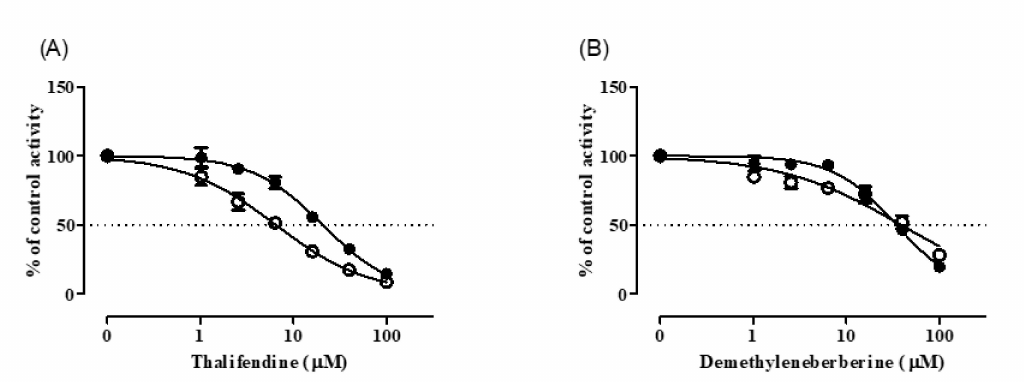
Figure 3. Changes in the inhibition curves of CYP2D6 by TFD ( A ) and DMB ( B ) after pre-incubation of pooled HLM with (empty circle, ) or without (solid circle, • ) NADPH for 30 min. The activity (cid:35) is expressed as the percentage of control samples containing no inhibitor (100%). Data show the mean ± SD of three separate samples.